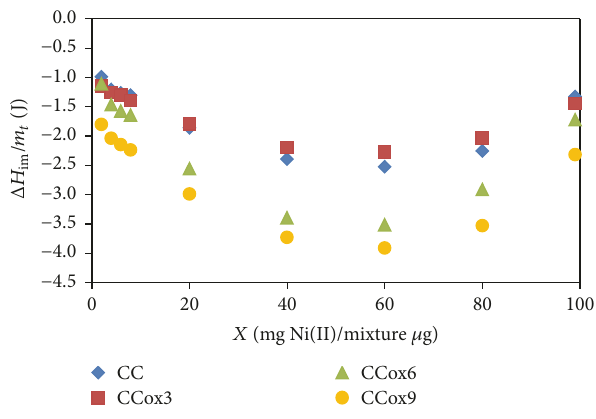
Figure 4: Immersion enthalpy per mixture mass as a function of the Ni(II) mass fraction.